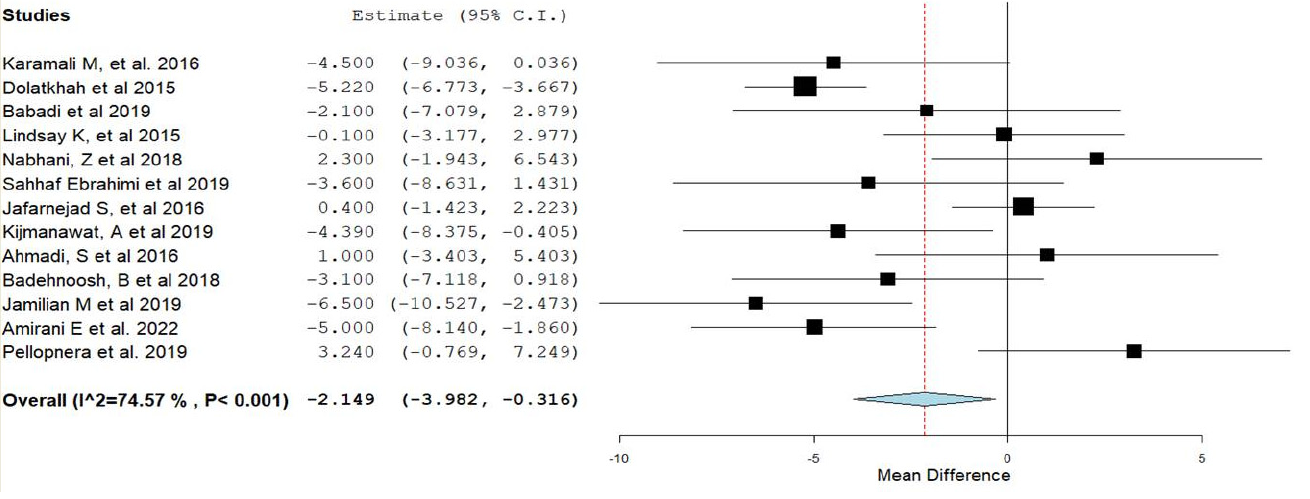
Figure 2. Forest plot of probiotic treatment versus placebo and fasting plasma glucose levels (mg/dL). C.I.: confidence interval [12,14,22–28,30,31,34,35].